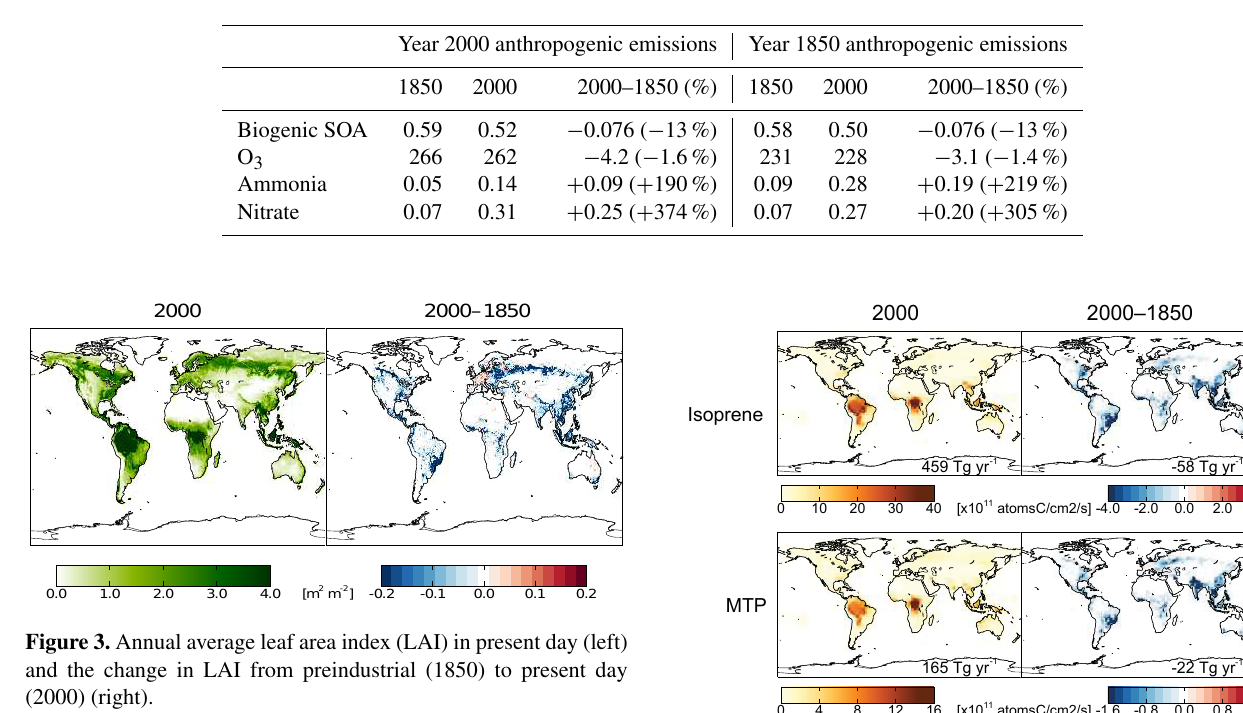
Table 4. Annual average tropospheric burden (Tg) of key species. Also shown is the changes driven by historical land use change (including